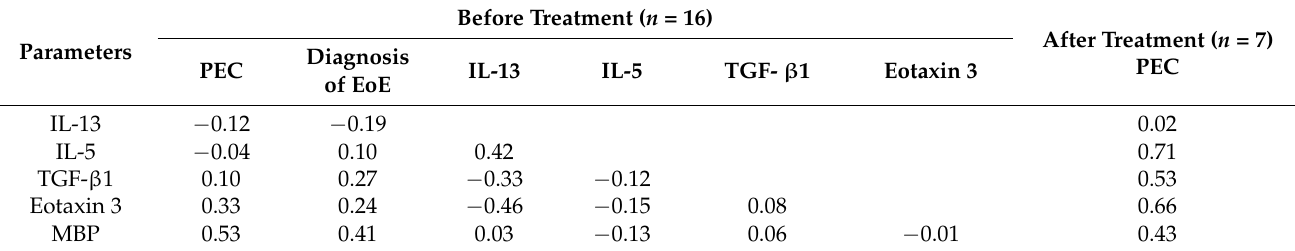
Table 2. Spearman’s rank correlation coefficients between biomarkers, diagnosis and PEC, before and after treatment.